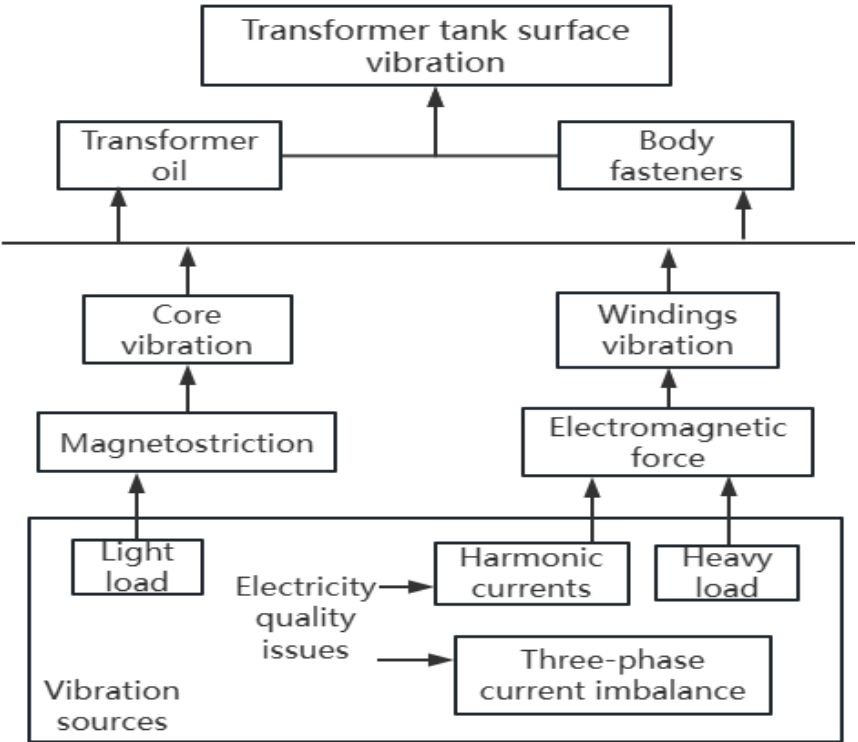
Figure 1. Transformer vibration mechanism model based on power quality.